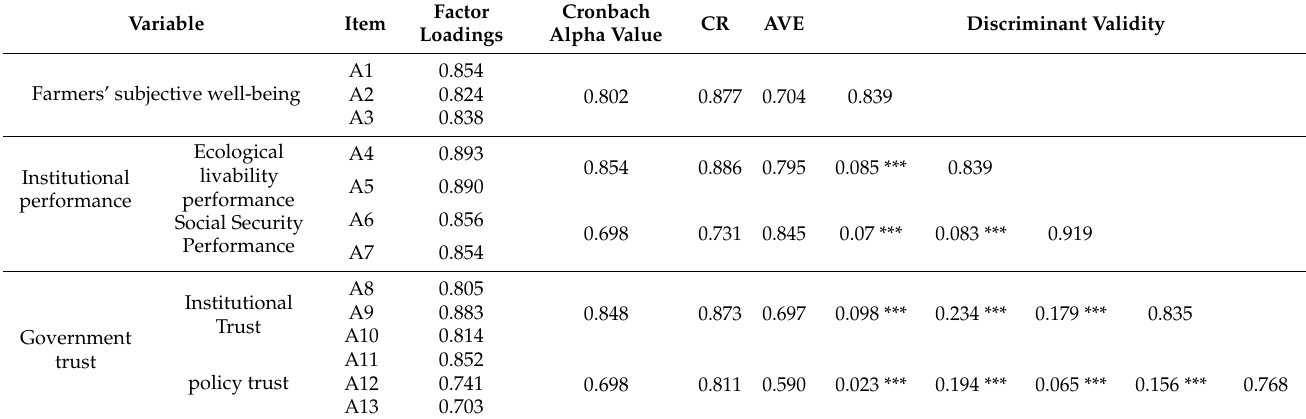
Table 3. Reliability and validity test